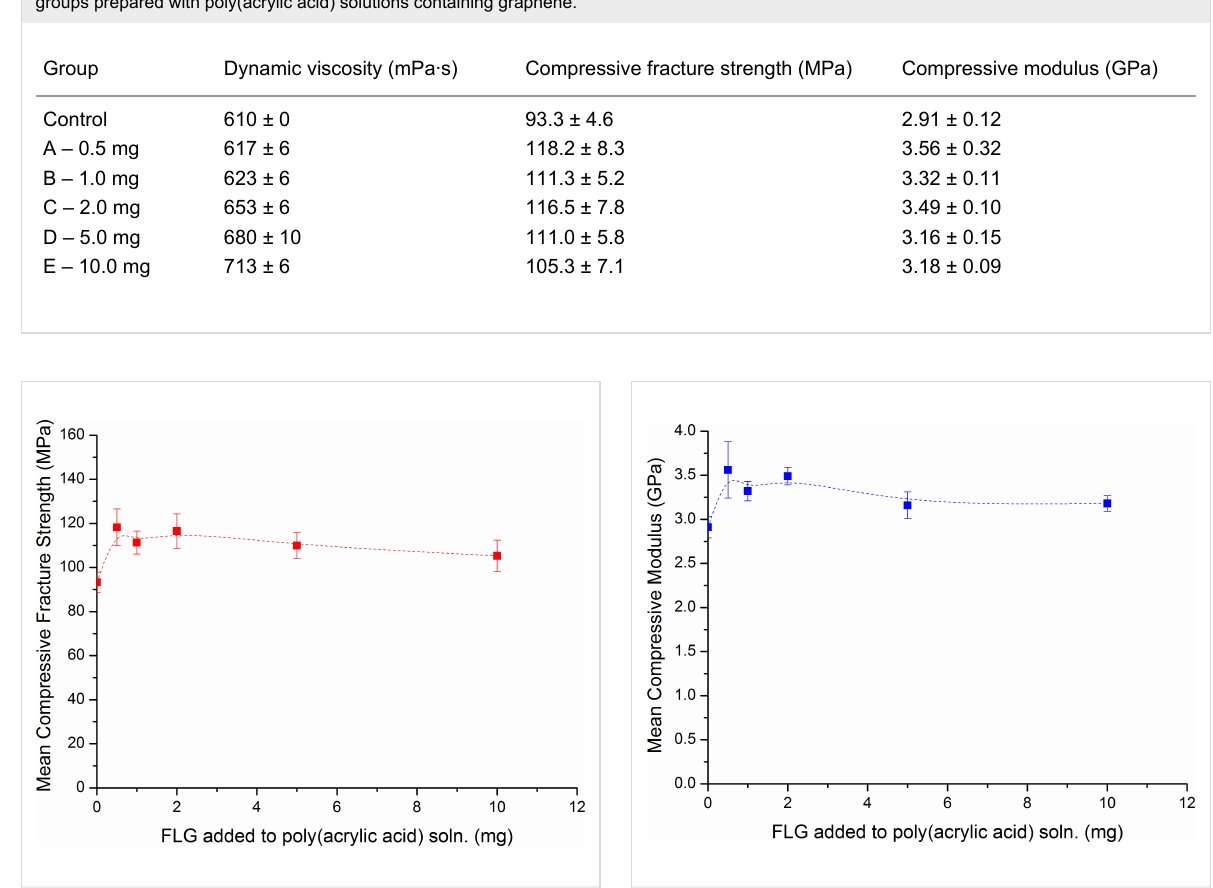
Figure 4: Change in mean compressive fracture strength with increas- ing graphene concentration.